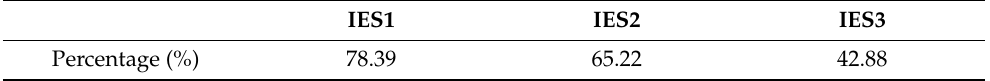
Table 16. Percentage of the P2H oxygen supply in the combined P2H - VPSA oxygen supply.